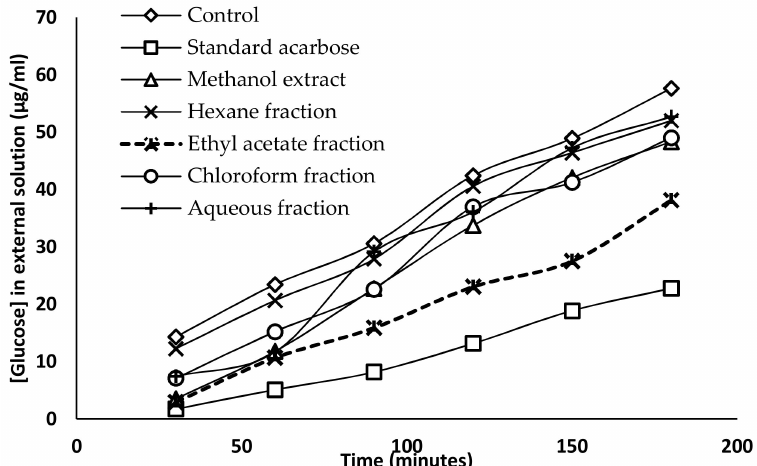
Figure 1. E ff ect of methanol extract and fractions of G. edulis (1000 µ g / mL) on glucose di ff usion through dialysis membrane compared to the standard acarbose and control. Data presented as means ± standard deviation ( n =